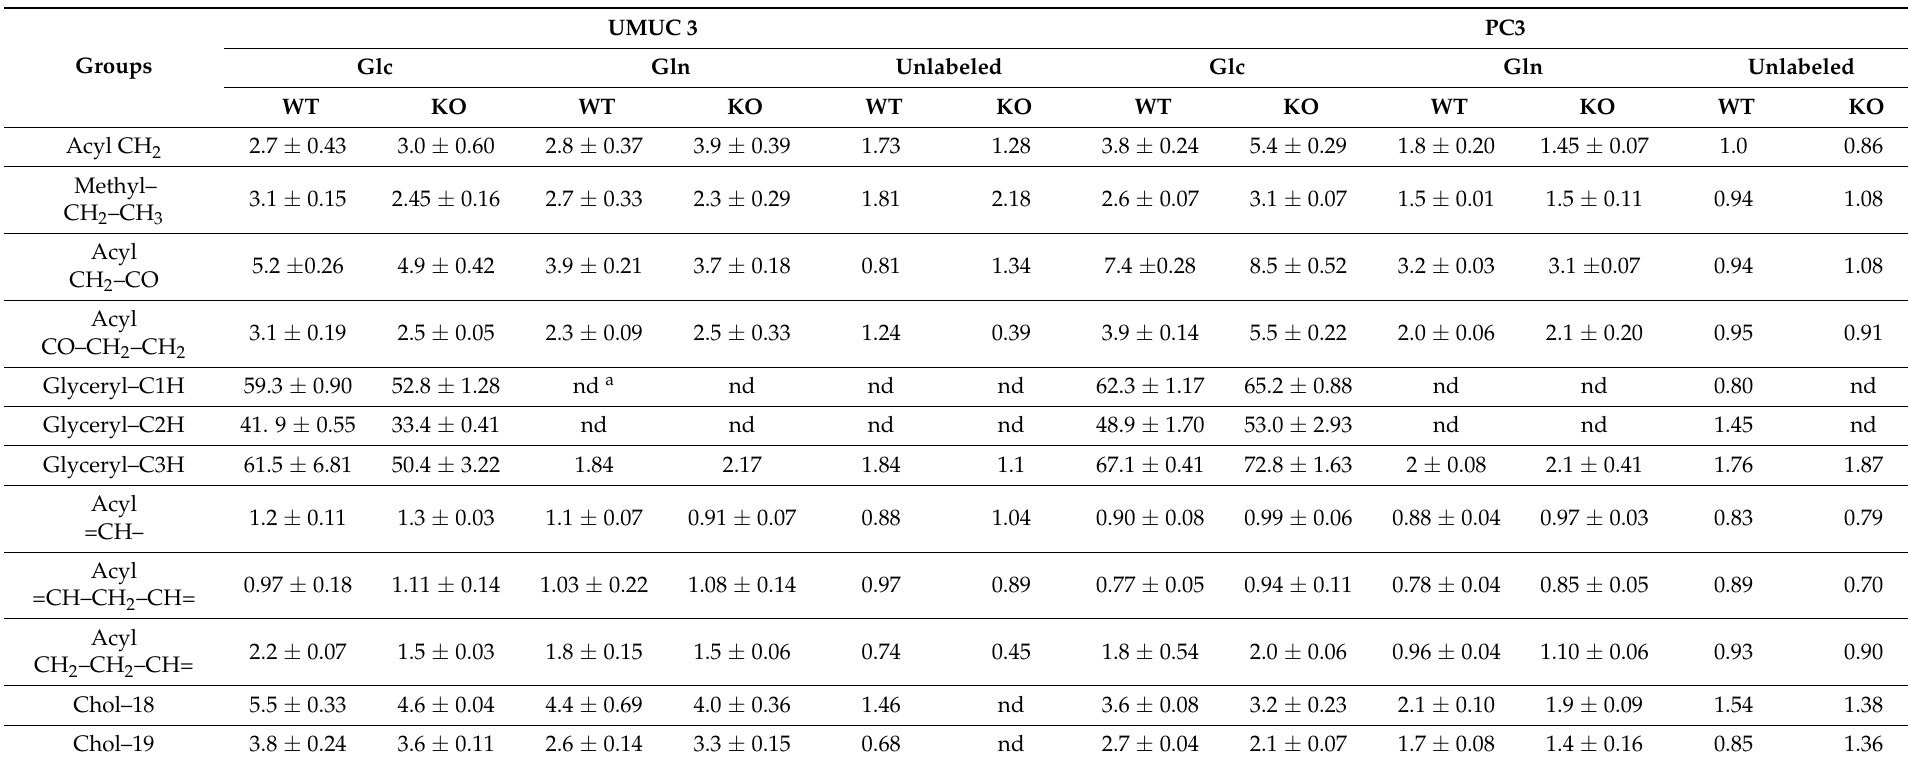
Table 1. Summary of fractional 13 C level in lipid subgroups from both cell lines (WT: wild type as well as KO: knock out) determined by NMR. Lipid subgroup 13 C levels were calculated as described in the text (Equations (1) and (2)) and are presented as % of the total carbon at different position in the lipids (mean ± standard deviation for triplicate labeled samples, only one unlabeled sample in each